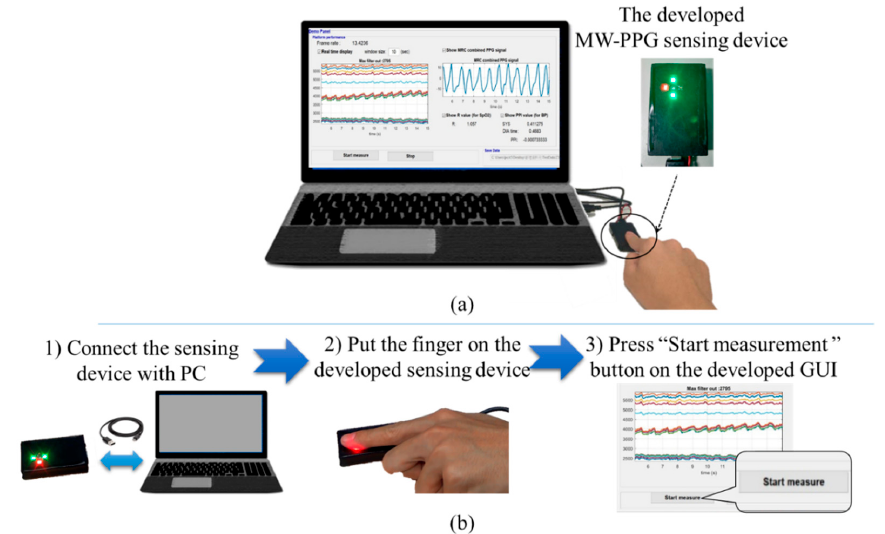
Figure 7. Operation of the developed MW-PPG prototype sensing device. ( a ) Snapshot of the MW- measurement setup; ( b ) Illustration of the operation PPG measurement setup; ( b ) Illustration of the operation sequence.